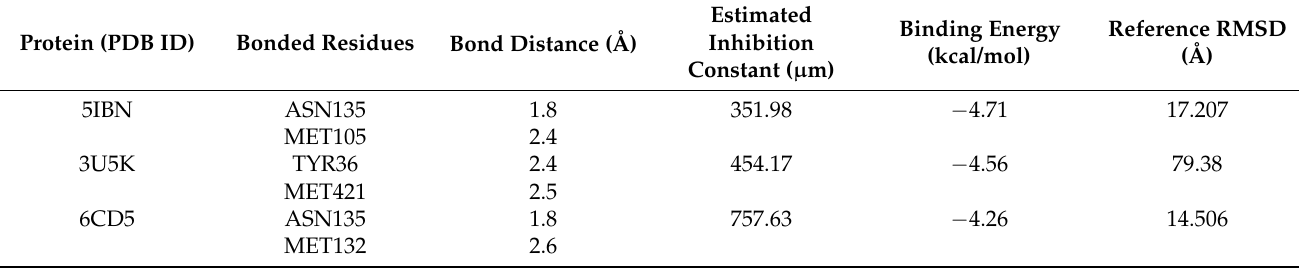
Table 7. Hydrogen bonding and molecular docking with protein